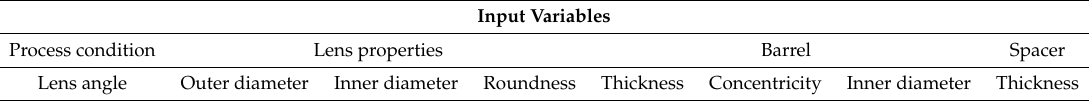
Table 2. Independent variables as inputs of